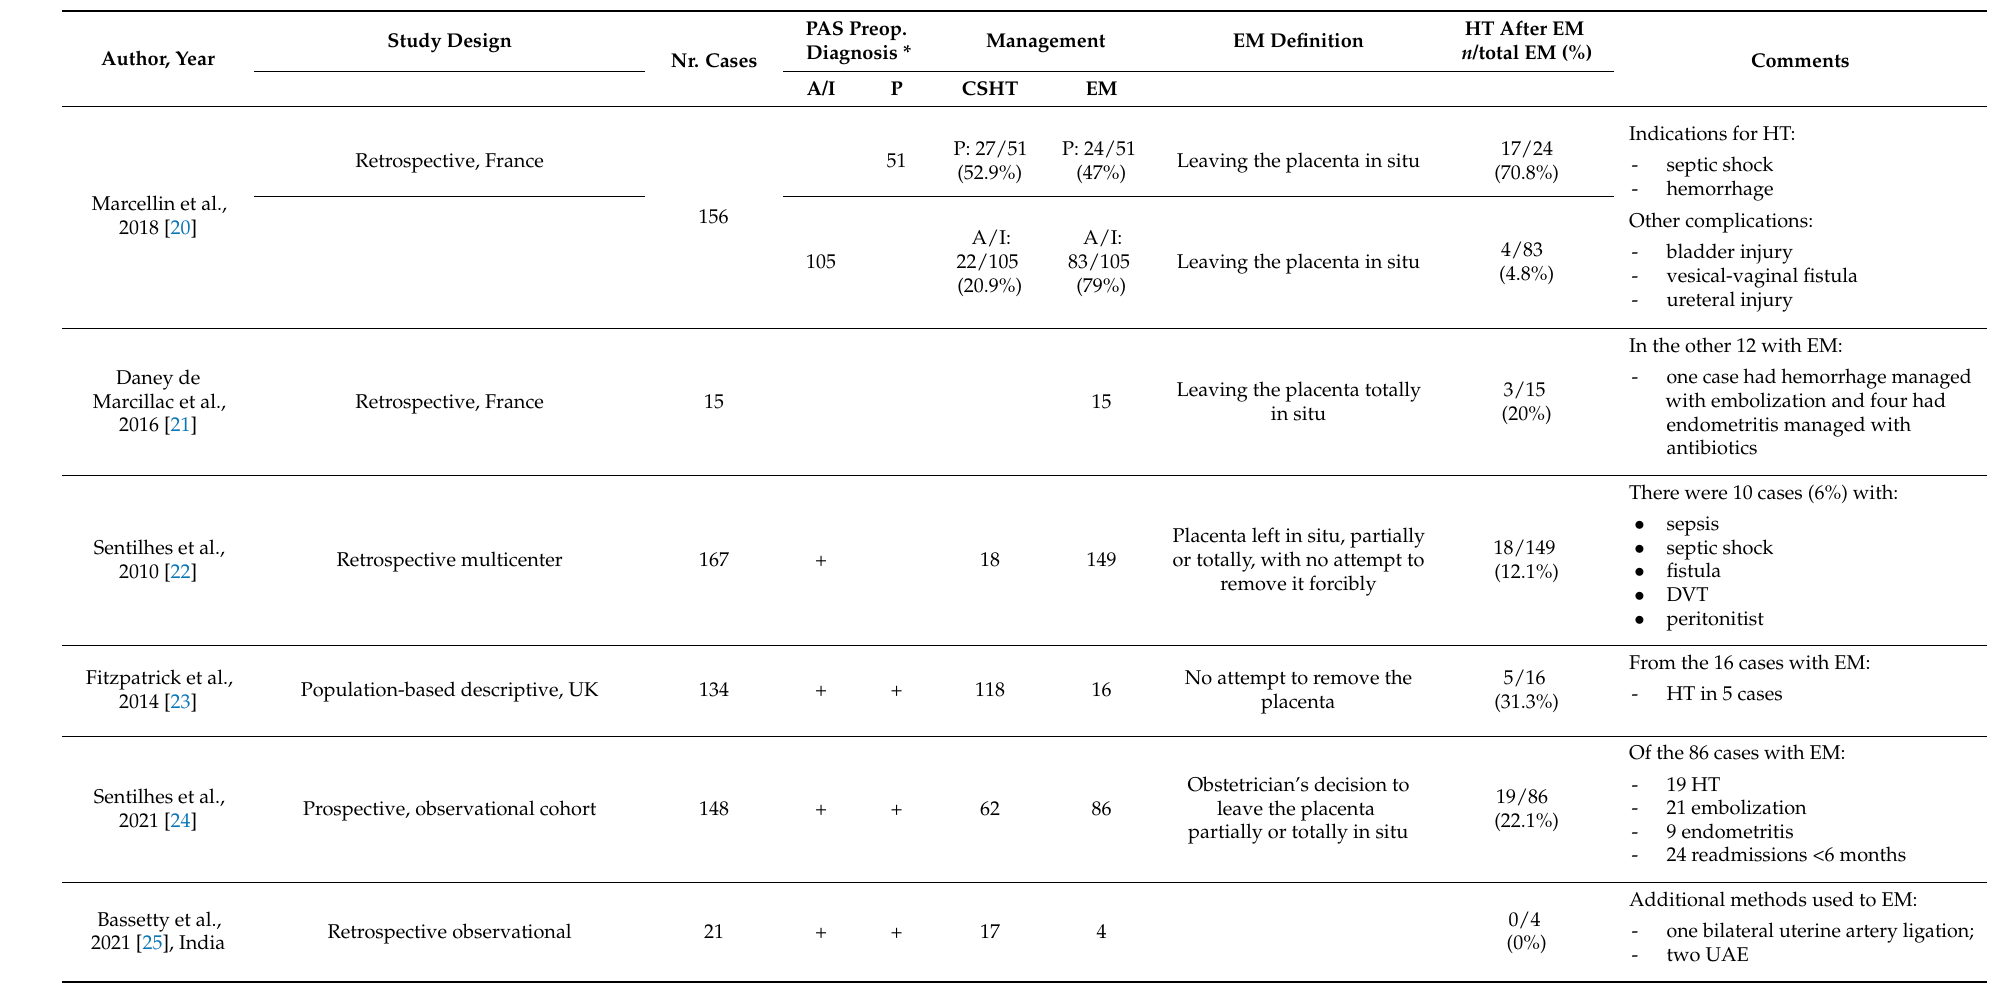
Table 1. Studies in which expectant management was